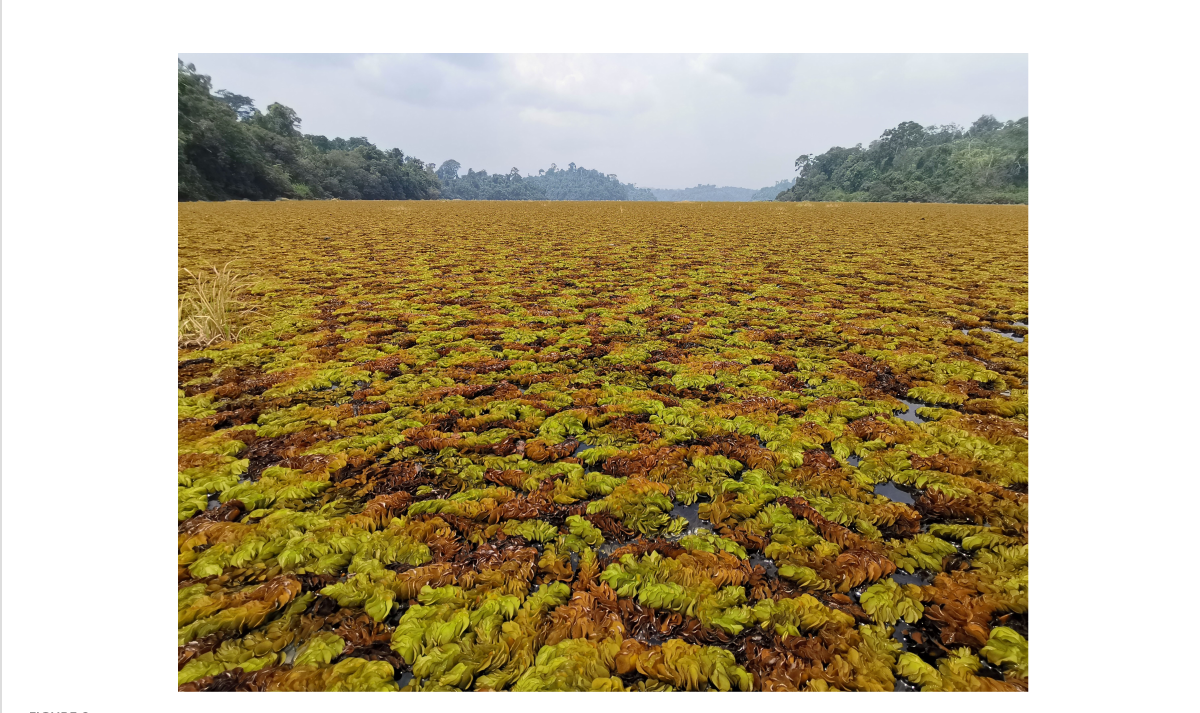
FIGURE 2 An area of Lake Ossa (Koungue) invaded by Giant